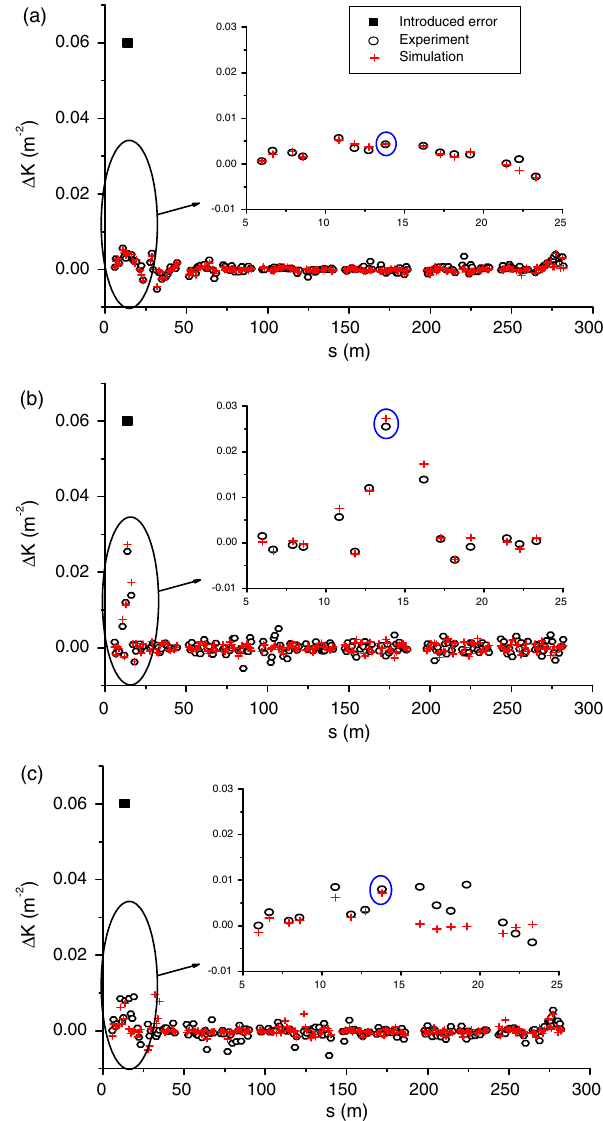
FIG. 8. Single error identification test. (a) QV, (b) LOCO, and (c) TBT. The singular value cuts are (cid:2) 0 : 02 , 0.001, and 0.01, respectively. The blue circle indicates the correction of the quad- rupole used to introduce the single error. The quadrupole correc- tion, without the intentionally introduced error, is